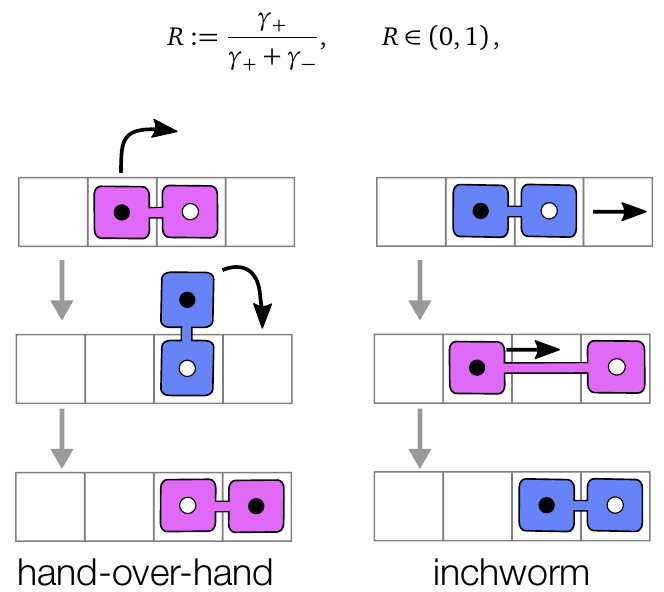
Figure 1: Illustration of the footprint of molecular motors with two active